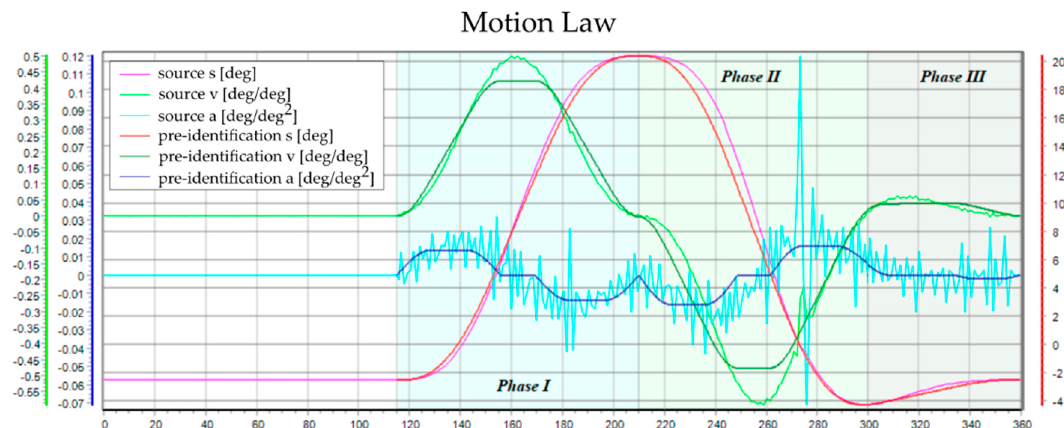
Figure 10. Comparison between the experimental law of motion (light blue) and modified trapezoidal laws for each phase (with equal coefficients values) as the starting point of the identification procedure (red: displacement; green: velocity; blue: acceleration). Table 7. Final values of the Euclidean norm and DTW algorithm on displacement, velocity and acceleration, in the simulated cases with laws of motion of the polynomial class used as the original law of motion. Figure 11. Comparison between the experimental law of motion (light blue) and modified trapezoidal laws for each phase (with equal coefficients values) after identification based on displacement by adopting EN.